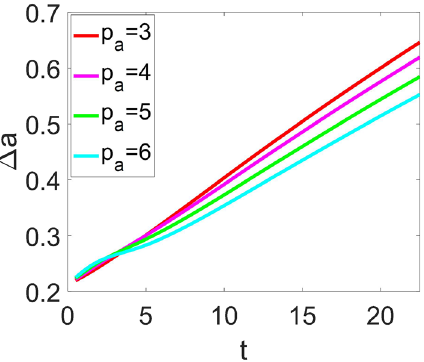
Fig. 13 Variations in the variance. The horizontal and vertical axes represent the time variable and variance, respectively. The parameters are taken as: α = 0 . 5, V 0 = 200